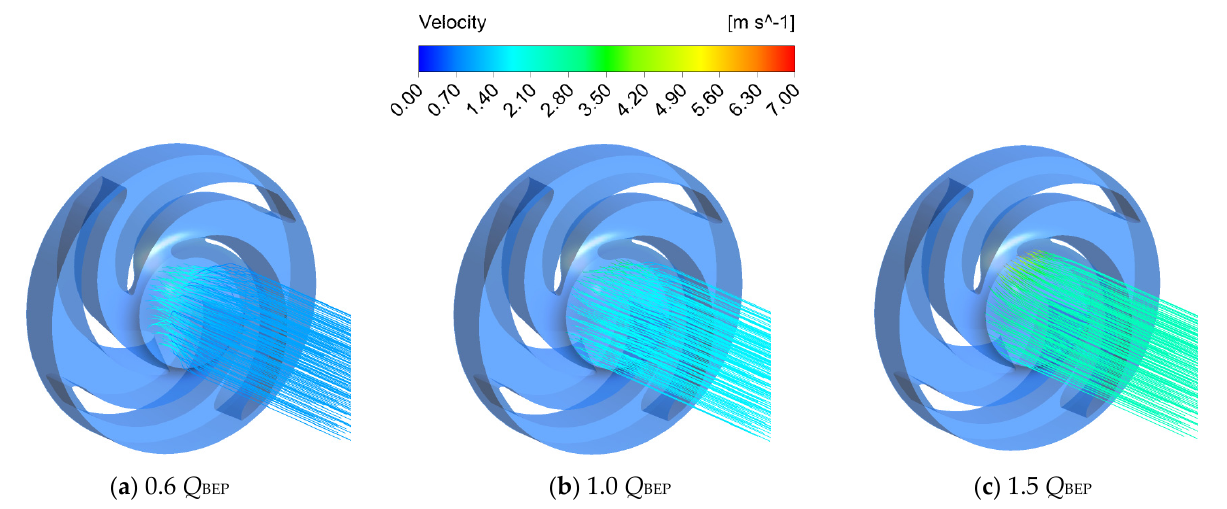
Figure 4. ( a – c ) Flow distribution in the inlet section under clean water.